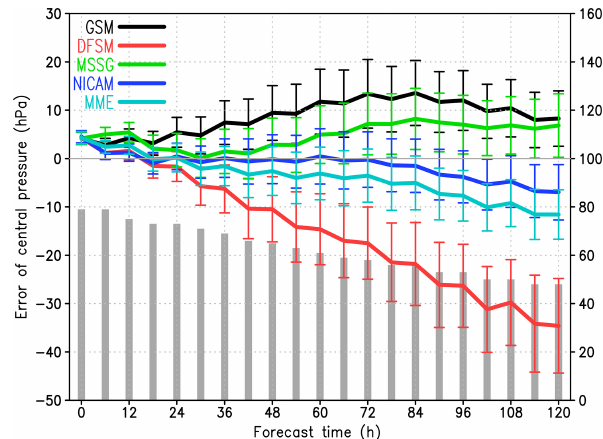
Figure 4. Errors in the predictions of the central pressure for GSM, DFSM, MSSG, NICAM and MME (in the second stage). Each grey bar indicates the number of samples at each forecast time (right- vertical axis). Error bars indicate 95% confidence levels of the central pressure difference between the prediction and the RSMC Tokyo best-track